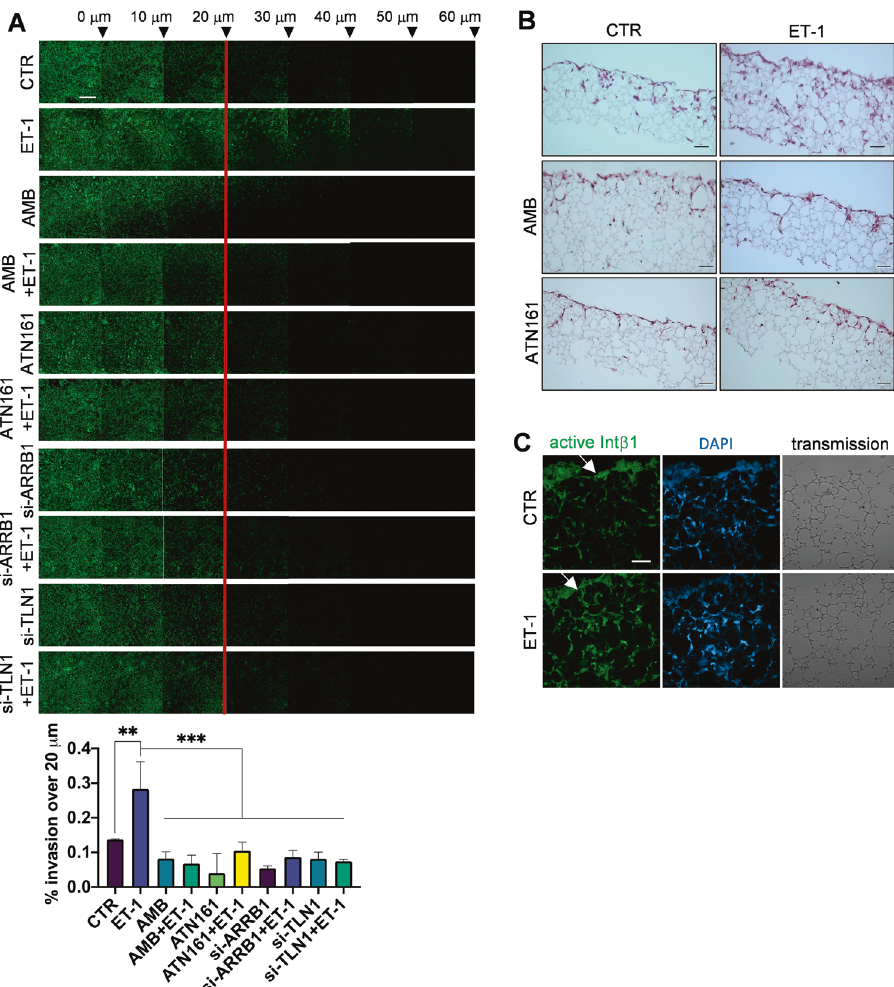
Fig. 7 HG-SOC invasion is regulated by ET-1/Int β 1 signaling. A si-SCR, or si-TLN1 or si-ARRB1 OVCAR3 cells treated with ET-1 and/or AMB and/or ATN161 were allowed to invade fi bronectin/type I collagen plugs in an inverted invasion assay (48 h). Cells were stained with PKH67, and serial optical sections (10 μ m intervals) were acquired. The invasion was measured by dividing the sum of signal intensity of all slides beyond 20 μ m (invading cells) by the sum of the intensity of all slides (total cells). n = 2, one-way ANOVA, Tukey post hoc analysis. Scale bar, 200 µm. B SKOV3 cells plated on a monolayer of MCs grown on fi bronectin/type I collagen in a polystyrene scaffold were allowed to invade for 7 days in the absence and presence of ET-1 and/or AMB and/or ATN161, then fi xed with Bouin ’ s solution and paraf fi n-embedded scaffolds were then cut into thin slices (10 µm). The images show cell invasion in a 3D organotypic model. Hematoxylin and eosin staining are shown. C Sections as in ( B ) were stained for active Int β 1 (green) and DAPI (blue) detection. The corresponding transmitted light images are also shown. Arrows depict the top side of the scaffold where cells were plated. Scale bar, 50 µm. Int α 5 β 1 signi fi cantly inhibited adhesion and spreading to push to expand our knowledge on how this tumor invades and intraperitoneal organs, and activation of Int β 1; (4) the co- metastasizes [34]. The intraperitoneal route of ovarian cancer expression of ET A R and Int β 1 in patients with HG-SOC correlated metastasis places unique demands on tumor cells, such as single or spheroids, requiring speci fi c molecular mechanisms [35, 36]. with poor prognosis, thus representing potential biomarkers of Cues from the ECM, heterotypic interactions between tumor and metastatic progression. stromal cells, and growth factor signaling are drivers of these Integrins are critical mechano-signal transducers mediating the processes [37]. Among these, the quality and strength of integrin- effects of ECM and cellular receptor signaling during tumor mediated signaling depend not only on the local ECM density/ progression [7, 38]. One aspect of their function is linked to the “ inside-out ” activation, which places tumor cells at a relative stiffness and cell contractility but also on the cell-intrinsic signaling network working in concert to steer the invasive advantage in the metastatic process [2, 3]. Previous studies machinery [2, 3]. The data in this study provide evidence of a established the primacy of Int β 1 function in determining the novel mechanism of integrin activation driven by ET A R/ success of ovarian cancer cell metastatic colonization, with a high β -arr1 supporting the metastatic process. Using primary HG-SOC tropism for intraperitoneal organs with a monolayer of MCs covering the underlying stroma [8]. Although the role of Int α 5 β 1- cells and cell lines, we found that (1) ET-1/ET A R promotes Int α 5 β 1 fi bronectin interaction has been described [8], the contribution of inside-out signaling via a functional interaction between β -arr1/ inside-out signaling has not been fully elucidated. Signals from Int β 1 and talin1; (2) this signaling enhances spheroid survival and GPCRs may lead to integrin subunit phosphorylation and inside-out mesothelial clearance competence with increased cellular con- integrin activation [4, 6]. Indeed, the interaction of GPCR- tractility and supports cell invasion; (3) targeting of ET A R as well as Cell Death and Disease (2023)